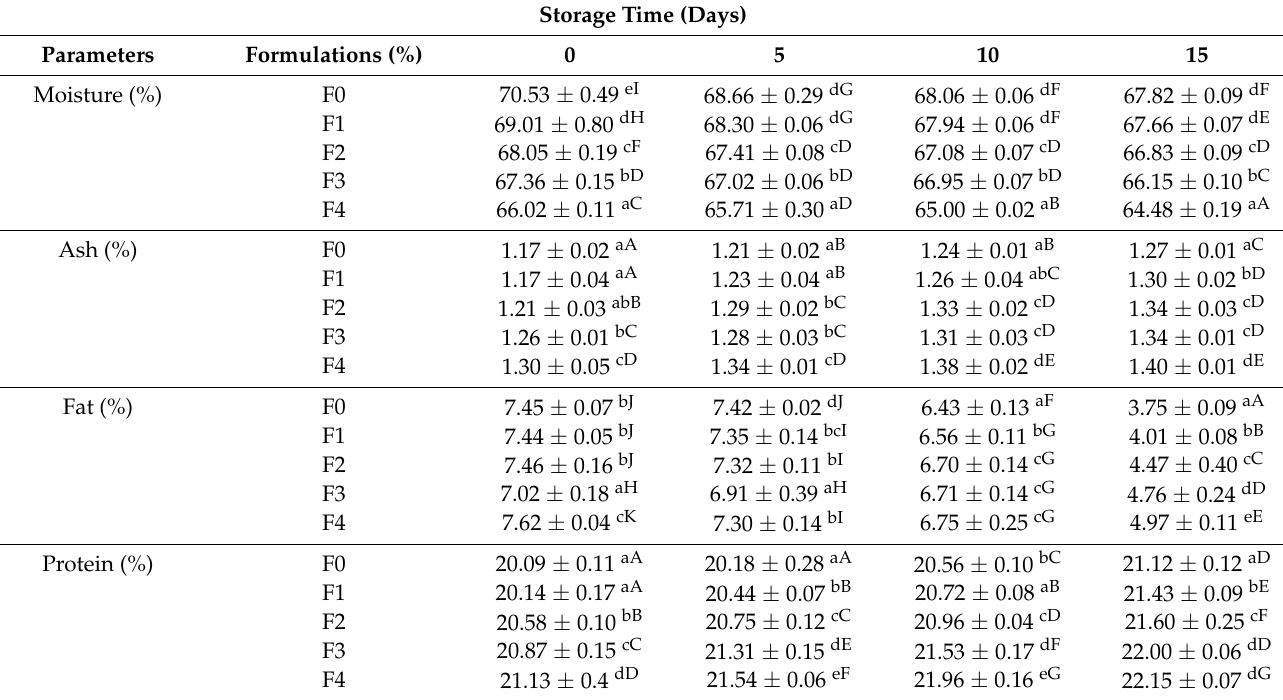
Table 1. Effects of Moringa oleifera leaves powder (MOLP) on proximate composition (dry basis) of ground beef stored at 4 ± 1 ◦ C for 15